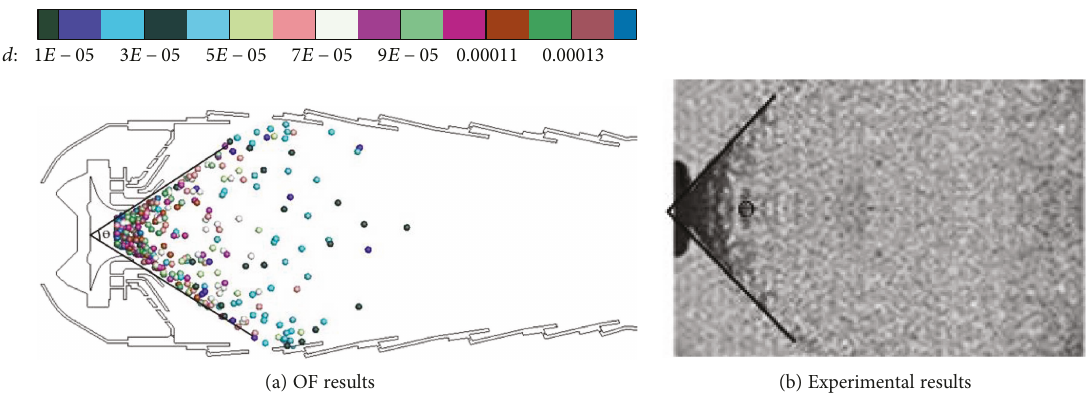
Figure 16: Spray droplet distribution comparison of OF and